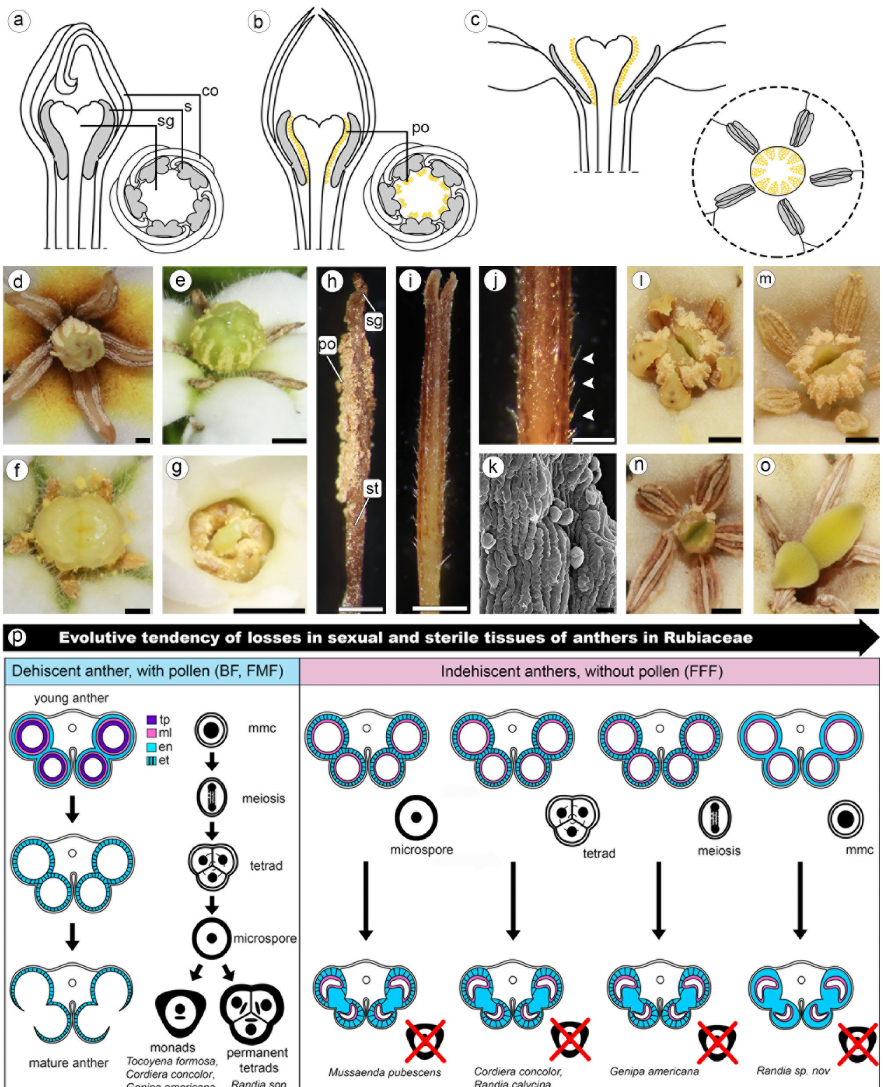
Figure 5. a-o , Mechanism of secondary pollen presentation. p, Hypothetical evolutionary tendency of losses of tissues of anthers in Rubiaceae taking into account an anther with normal development of its tissues versus abnormal anthers. a-c, Representative outlines of the stages of the presentation mechanism in lateral (left) and apical (right) views. a, Phase 1 (young bud). b, Phase 2 (pre-anthesis at beginning of the floral anthesis). c, Phase 3 (post anthesis). d-f, Pollen is presented on the stigma surface. d, Genipa americana, e, Randia calycina, f, Randia heteromera g-k , Cordiera concolor, pollen is presented on the style surface. h, Lateral view of the style with pollen (fixed material). i, Lateral view of the style without pollen, note the furrows on its surface (fixed material). j, Detail of the surface of the style with trichomes. k, Detail of the surface of style close to a furrow where the pollen grains are retained (SEM). l-o, Protandry in Tocoyena formosa. l-m, Phases 2 and 3 of secondary pollen presentation, stigma with pollen on the surface. n, The pollen was removed by the pollinators from the stigma surface. o, The branches of stigma unfold. p, At the left, the anthers of the FSF or PF with a normal development of their tissues and pollen are represented, while the abnormal anthers of the FPF are represented to the right. The top row corresponds to anthers when pollen development stops (stage X) and the bottom row corresponds to indehiscent anthers with collapsed pollen sacs and aborted tissue. Abbreviations: en= endothecium without thickenings; et= endothecium with thickenings; ml= middle layers; mmc= microspore mother cells; po= pollen; sg= stigma; st= style; tp= tapetum. Scales: d-g, 1 mm; h-i, 0.5 mm; j, 0.2 mm; k, 20 µm; l-o, 2